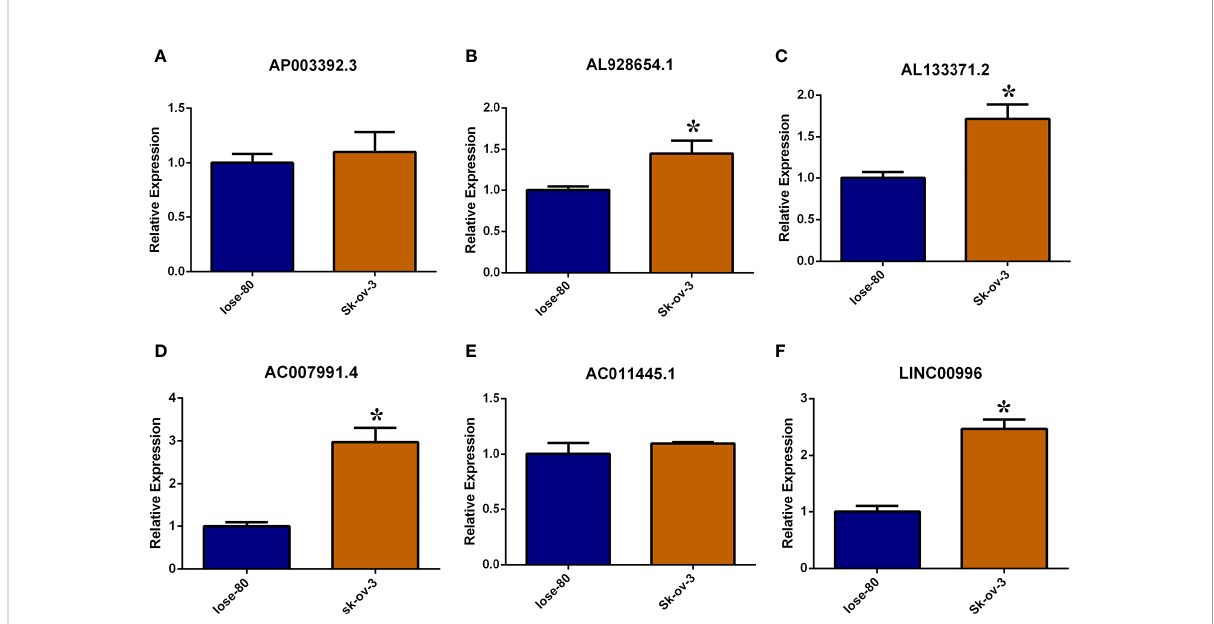
FIGURE 7 Validate necroptosis-associated lncRNAs in risk model by RT-PCR method. (A – F) Relative expression of AP003392.3, AL928654.1, AL133371.2, AC007991.4 AC011445.1 and LINC00996 in Iose-80 and Sk-ov-3 cell line. *: p <